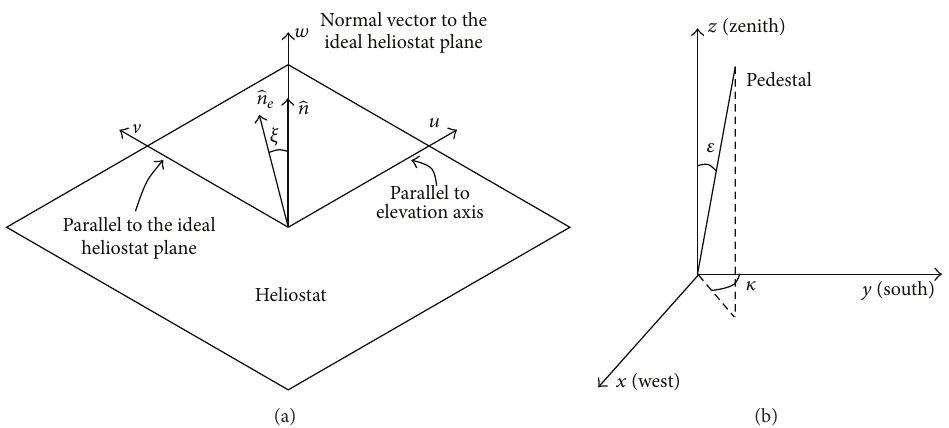
Figure 3: The coordinate system (a) shows the canting error in the local system. The coordinate system (b) shows the global reference.